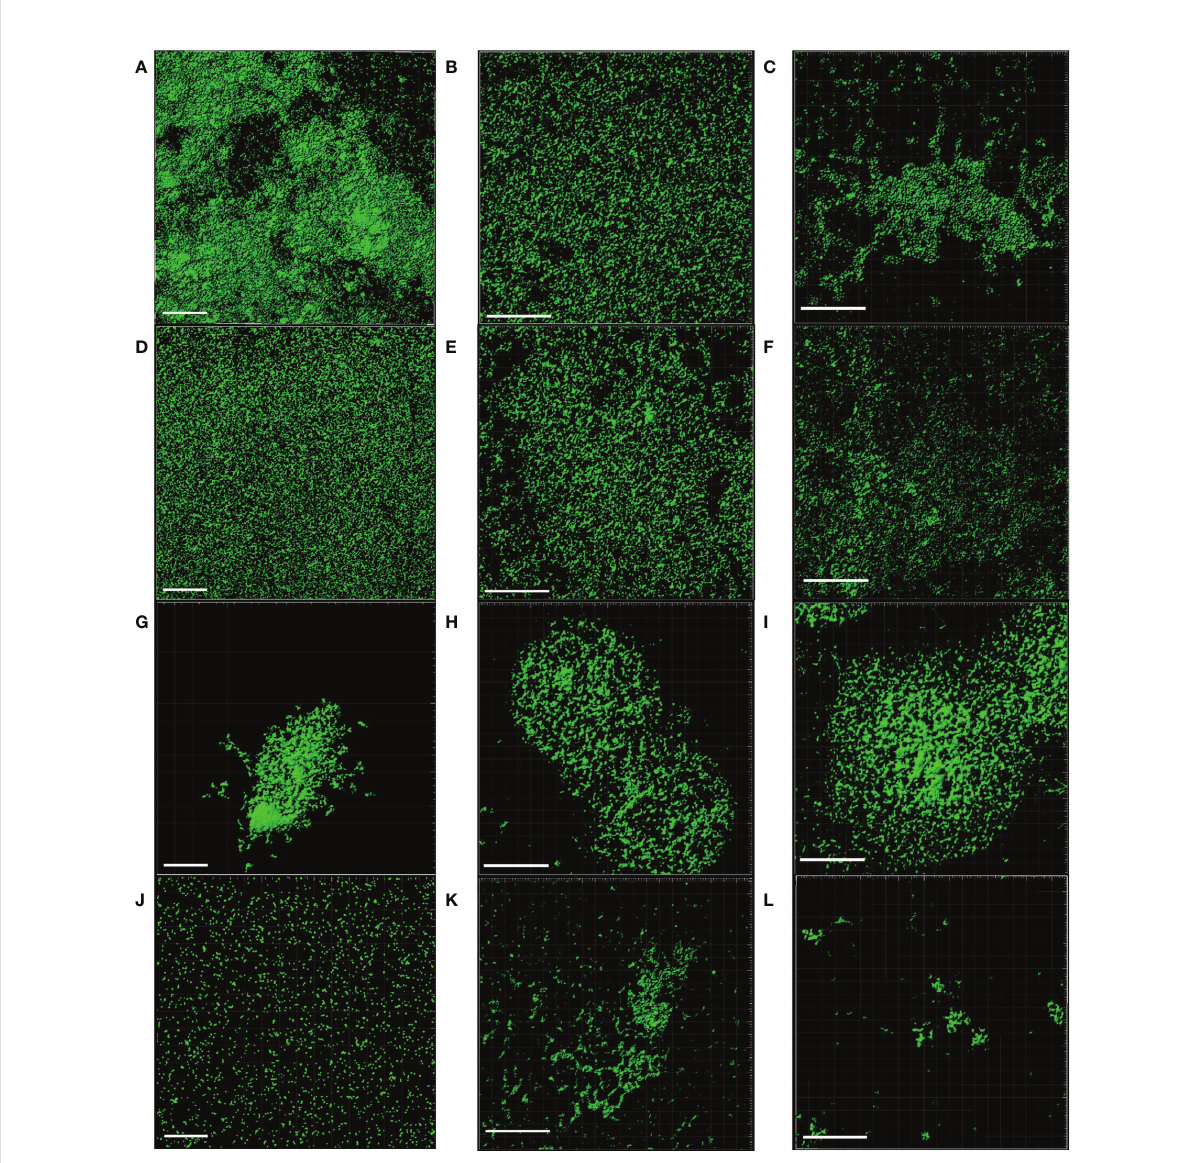
FIGURE 6 Representative CLSM images of monospecies bio fi lms (48 h) of K. pneumoniae 9SNG3 (A) , S. marcescens 10SNG3 (D) , S. aureus 45SNG3 (G) and S. epidermidis 46SNG3 (J) . Representative CLSM images of dual-species bio fi lms of K. pneumoniae 9SNG3 (B) , S. marcescens 10SNG3 (E) , S. aureus 45SNG3 (H) and S. epidermidis 46SNG3 (K) with L. reuteri 7SNG3. Representative CLSM images of dual-species bio fi lms of K. pneumoniae 9SNG3 (C) , S. marcescens 10SNG3 (F) , S. aureus 45SNG3 (I) and S. epidermidis 46SNG3 (L) with L. salivarius 20SNG2. Scale bar: 50